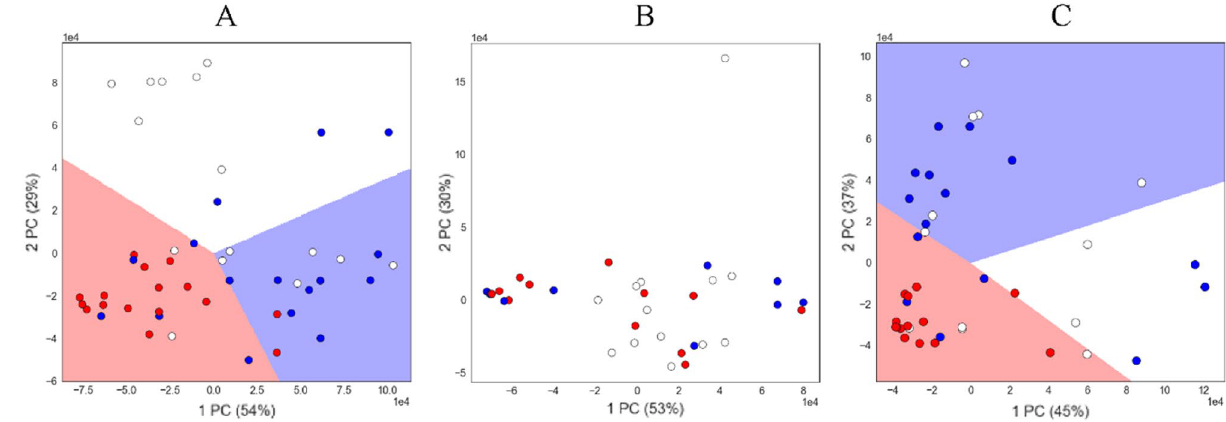
Figure 5. Results of applying PCA to mass spectra for three groups by day after tissue transplantation: ( A ) 1–3 day, ( B ) 4–5 days, ( C ) 7–8 days. White circles are urine samples from intact mice, blue circles are urine samples from mice with transplanted healthy liver tissue, red circles are urine samples from mice with transplanted hepatocarcinoma tissue. The urine samples spreading over the days after tissue transplantation are presented in Table 3.